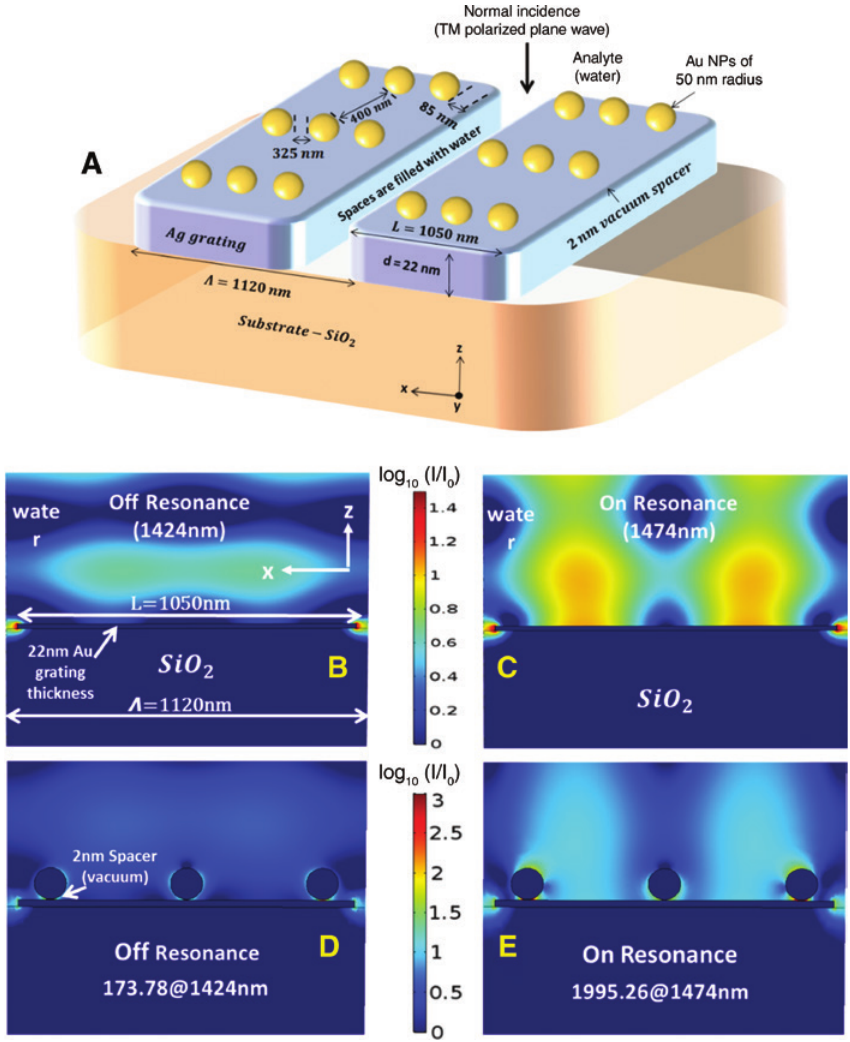
Figure 21: Field distribution under EOT with and without metal NPs. (A) Schematic of the nanograting on the substrate used for the EOT simulation. (B–C) Field distribution off resonance and on resonance. (D–E) Field distribution with three Au spheres on top of the grating lines at off-resonance and resonance